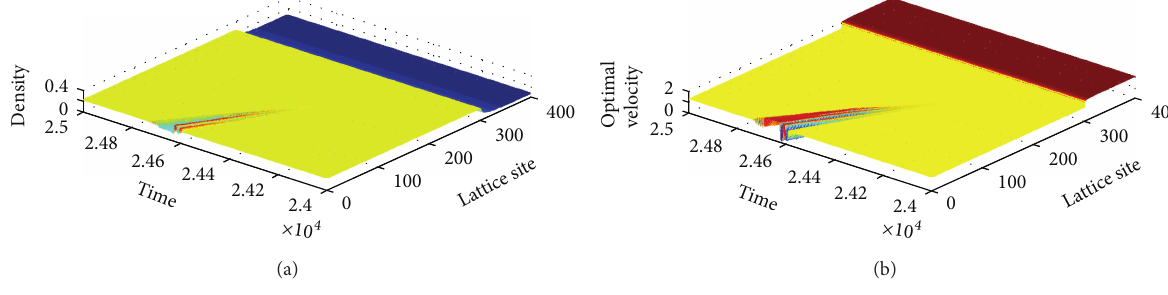
Figure 10: The spatiotemporal evolutions for 𝜌 ℎ = 0.05 , 𝑄 on = 0.15